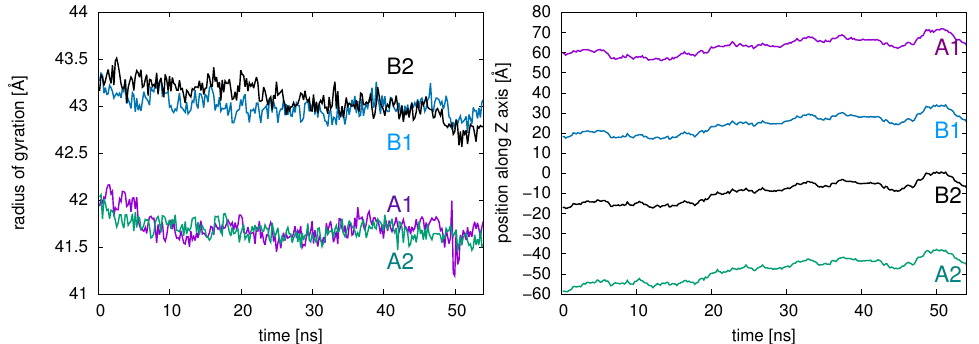
Figure 5. ( A ) The radius of gyration (Å) and ( B ) the position along the Z -axis of each ring’s C.O.M. is shown for each of the four ring systems A 1 (purple), B 1 (blue), B 2 (black), and A 2 (green) over the 54 ns simulation